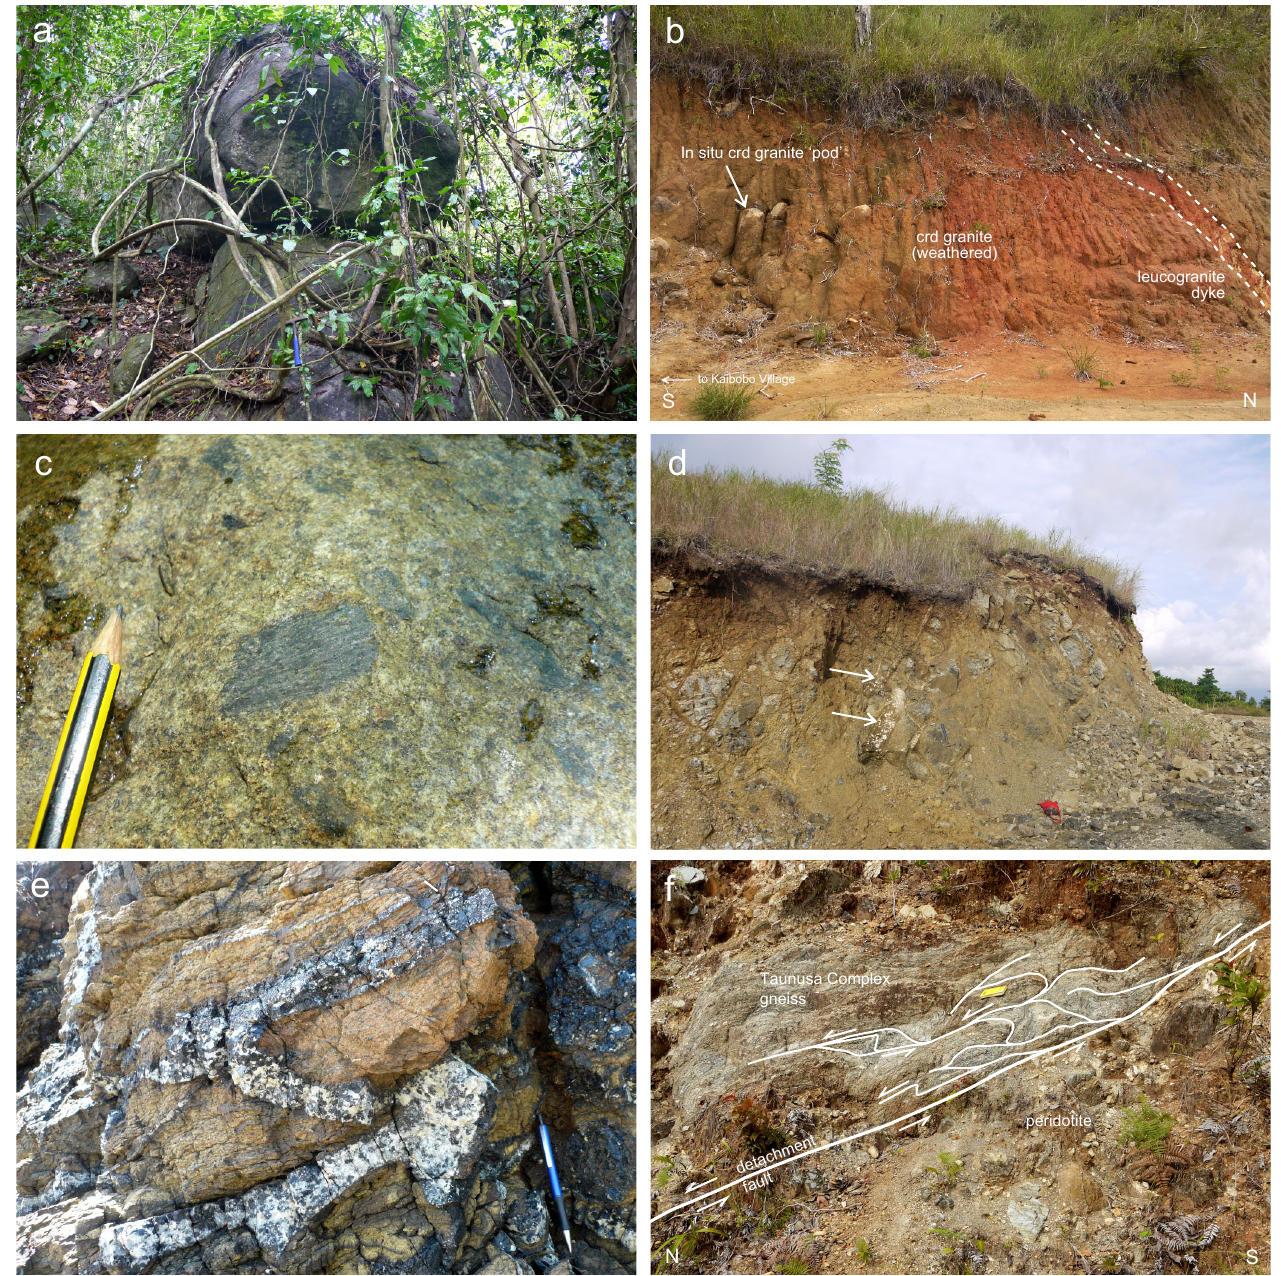
Fig. 7. Field relations on the Kaibobo Peninsula. (a) Typical cordierite granite boulder of the North Kaibobo Granite (128.1740 ◦ E, 3.1882 ◦ S); (b) Pods of in situ cordierite granite (left) which have escaped the weathering that has affected the rest of the exposure. A leucogranite dyke (right) has intruded these weathered cordierite granites (128.1787 ◦ E, 3.2005 ◦ S); (c) Sillimanite-spinel-corundum- cordierite schlieren within a cordierite granite boulder, South Kaibobo Granite (128.2004 ◦ E, 3.1833 ◦ S); (d) Leucogranite dykes (marked by arrows) within serpentinised peridotites adjacent to the granite-peridotite contact, South Kaibobo Granite (128.1734 ◦ E, 3.2102 ◦ S); (e) Peridotite on Tanjung Sisi net-veined by pegmatitic hornblende granodiorite (128.1596 ◦ E, 3.1592 ◦ S); (f) Detachment fault exposed in a roadcut (inland from the Kaibobo Peninsula between Piru and Waisarisa) separating Taunusa Complex gneiss and diatexite (above) from exhumed peridotites (below). A top-to-the-north shear sense is indicated by the folding in the gneisses in response to southward exhumation of the peridotite beneath the detachment (128.2444 ◦ E, 3.1231 ◦